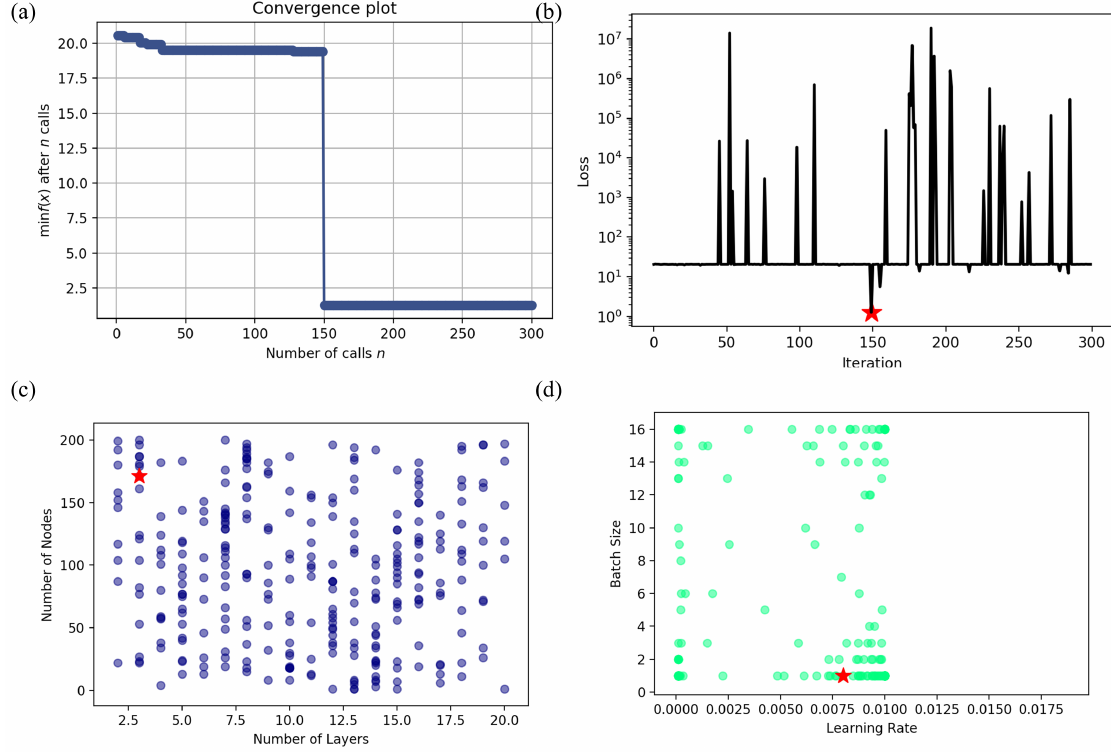
Figure 7. Results for the USA dataset. ( a ) minimum validation accuracy over iteration, ( b ) loss over iteration, distribution of ( c ) number of layers and hidden nodes, and ( d ) learning rates and batch size. (The red stars represent optimum